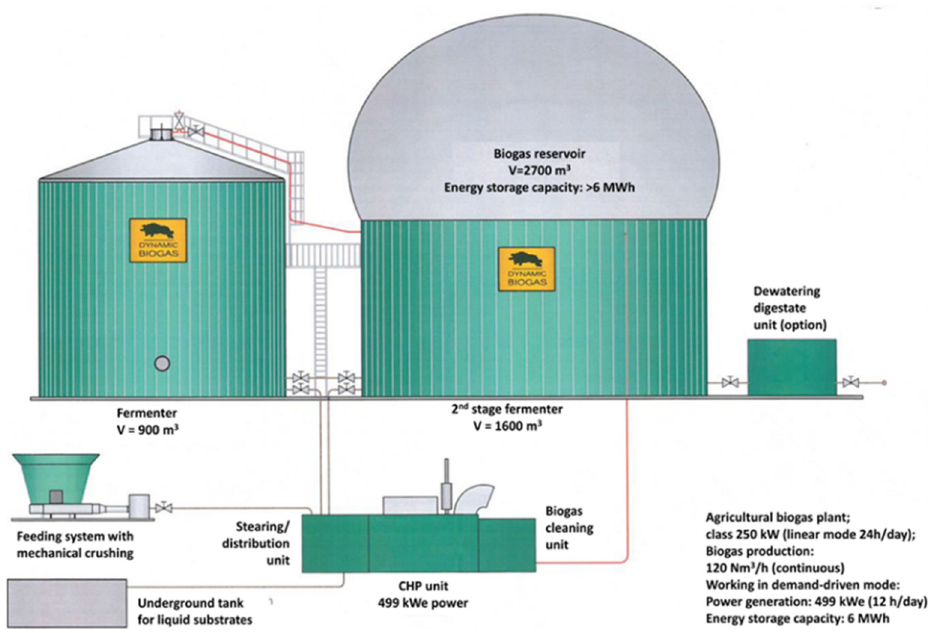
Figure 1. Diagram of operation of a 499 kW demand-driven biogas plant with energy storage (Dynamic Biogas Company).